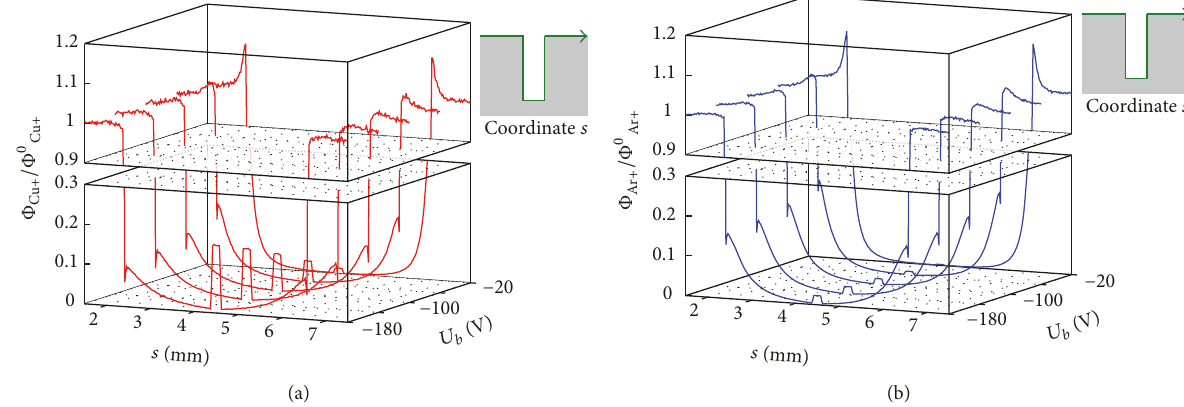
Figure 6: Flux of (a) Cu + and (b) Ar + ions along the trench boundary for different biases. RF power 𝑃 = 1000 W. Φ 𝑋 means flux of particles 𝑋 along the trench; Φ 0 𝑋 to a planar substrate without trench. Coordinate 𝑠 starts on the edge 𝑋 is a constant that describes flux of particles of the domain (0mm), reaches the beginning of the trench (2.4 mm), then the bottom (4.4 mm), goes along the bottom (4.4–4.6 mm), then along the side (4.6–6.6 mm), and continues on remaining planar part of substrate (6.6–9